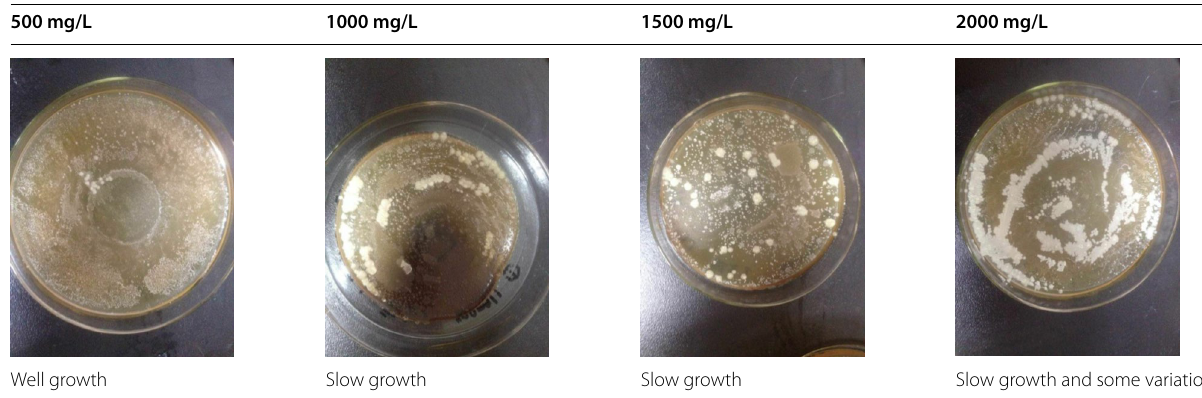
Table 2 Colony morphology of Pb 2 + medium